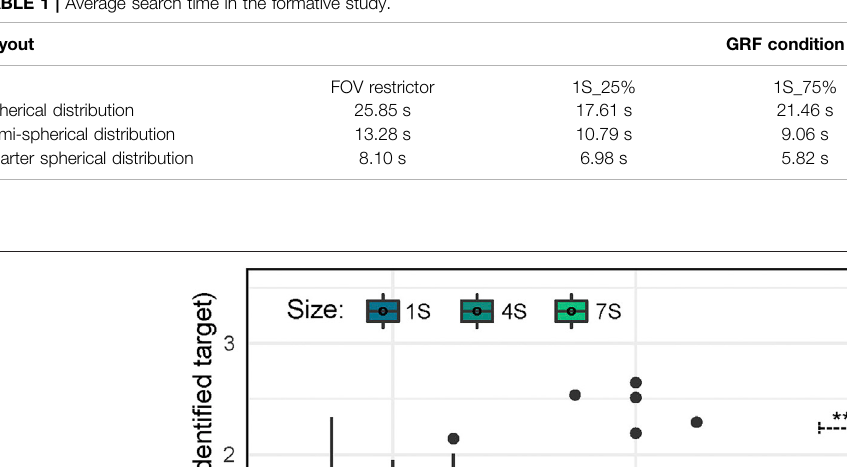
Frontiers in Virtual Reality |